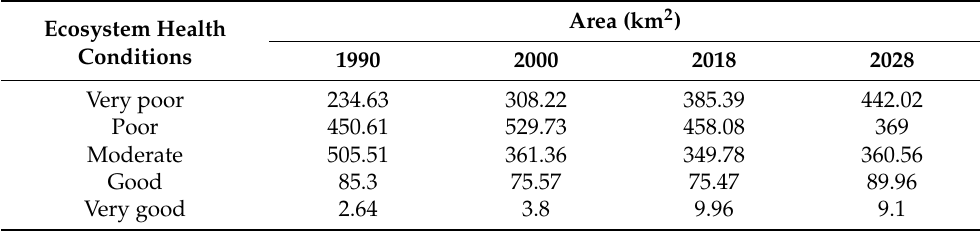
Table 4. Area coverage of different ecosystem health conditions for 1990, 2000, 2018, and 2028. Ecosystem Health Conditions